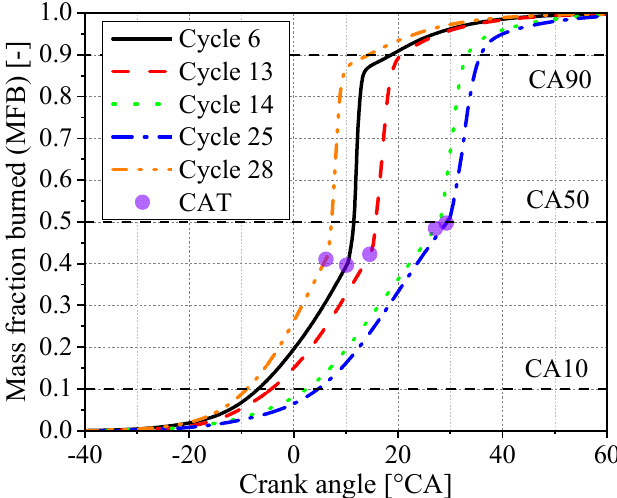
Figure 11. The mass fraction burned profiles for Cycle 6, Cycle 13, Cycle 14, Cycle 25 and Cycle 28. The distributions of flow magnitudes and vectors at 670 ◦ CA (just before spark ignition timing) are shown in Figure 12. The sections used for the distribution plots are also marked in the figure. It is visible that the flow velocity magnitude in the area around the spark plug is lower (in blue color) for Cycles 14 and 25. The flow velocity vectors captured in-cylinder flow motions and they are very different at the spark plug region among the cycles, which implies the potential impact on the flame kernel formation and initial development of the flame propagation process. In Cycle 12, there is a strong flow across the spark plug region towards the upper part of the horizontal plots. An anti-clockwise tumble towards the spark plug gap is also observed in the vertical plot. Similarly, strong flow motions are observed across the spark plug region towards the upper part of the cylinder in the horizontal plot of Cycle 28, while a clockwise tumble motion towards the spark plug gap is formed in the vertical plot. In comparison, a relatively weaker flow motion pointing to the spark plug is observed in Cycle 13, while the clockwise tumble in the vertical plot is slightly away from the spark plug gap. However, there is no coordinated flow motions across the spark plug region in Cycles 14 and 15.